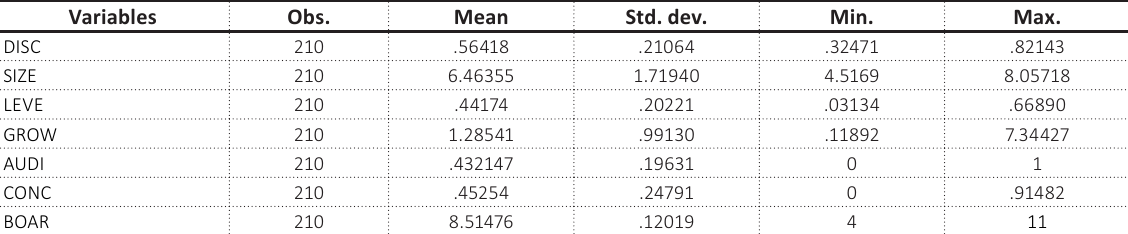
Table 2. Descriptive